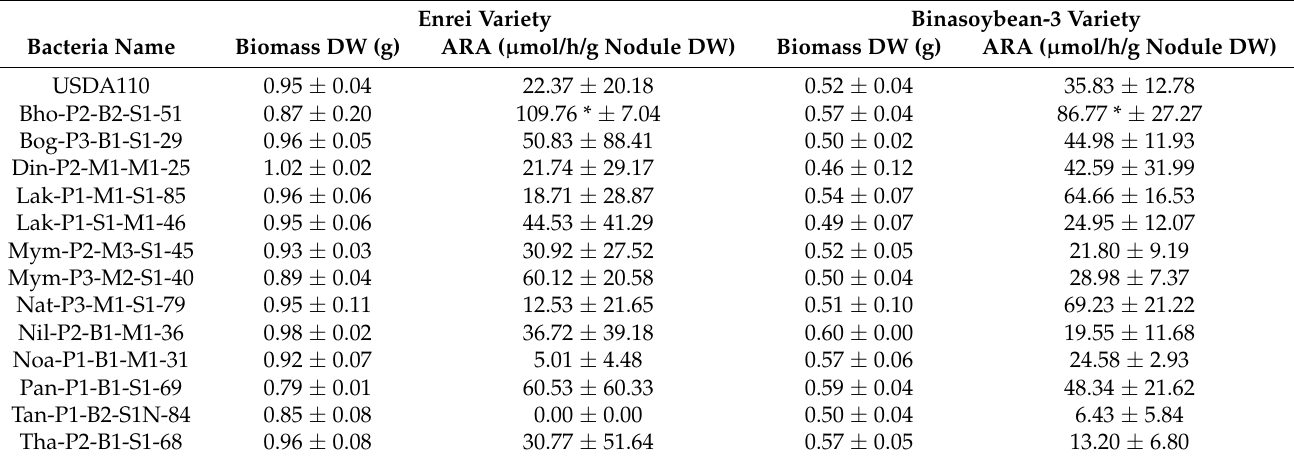
Table 3. Biomass dry weight (DW) and ARA activity in soybean Enrei variety and Binasoybean- 3 variety inoculated with isolated bacteria and B. diazoefficiens USDA110. All experiments were performed in triplicate and the data are expressed as the mean ±